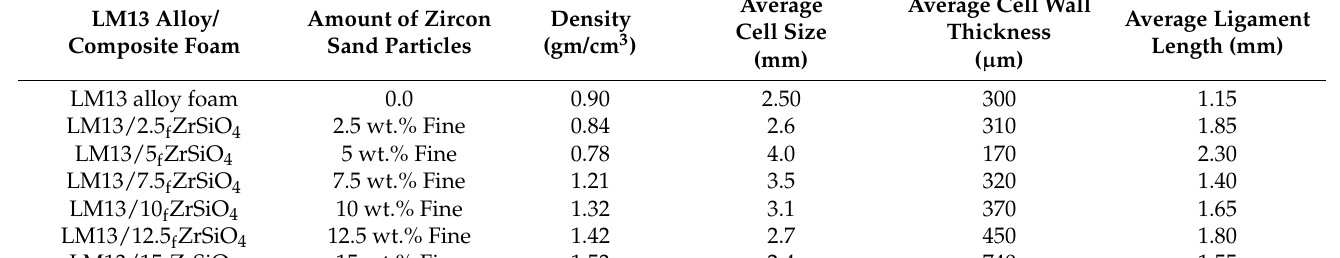
Table 4. Effect of the amount of zircon sand on the cell parameters and density of LM13 alloy foam and its composite foams (subscript ‘f’ shows for fine particles).